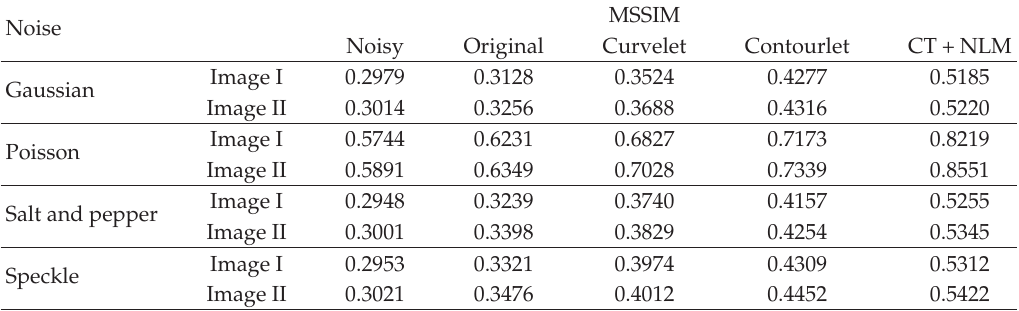
Table 2: MSSIM results.